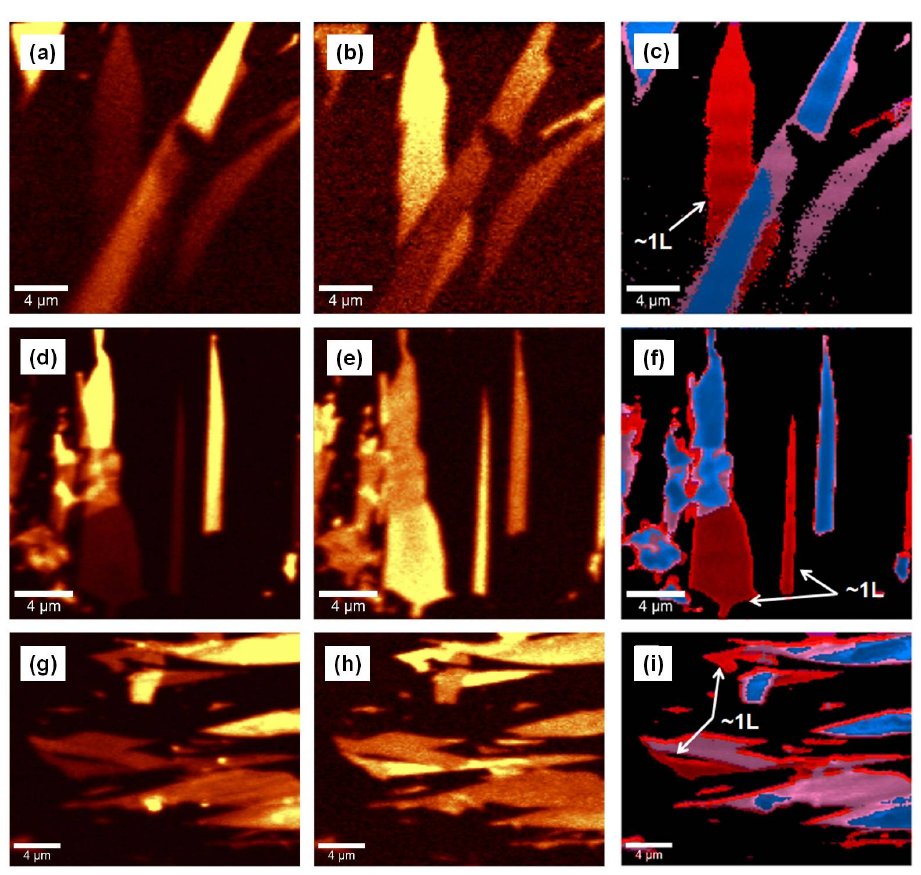
Figure 2. Confocal Raman mapping images screening: ( a , d , g ) the location of the G band; and ( b , e , h ) the location of the 2D band. Yellow pseudo-color in the images corresponds to higher intensity of the filtered Raman feature; ( c , f , i ) Images preformed with Cluster Analysis software (Ulm, Germany) revealing a mixture of a single-layer and a few-layers of graphene. The arrows mark the presence of a single-layer of graphene in the samples.